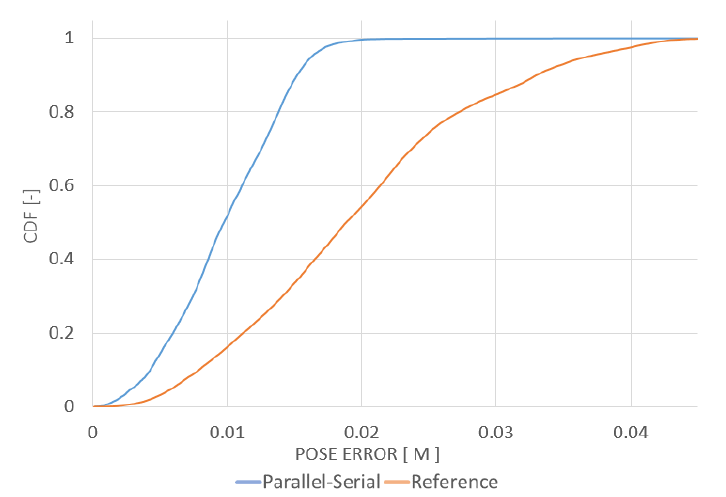
Figure 10. CDF of the position error relative to the ground-truth path with parallel-serial localization on the path projected in Figure 7. The orange line shows the reference localization algorithm results from [66], while the blue line shows the results of our method.